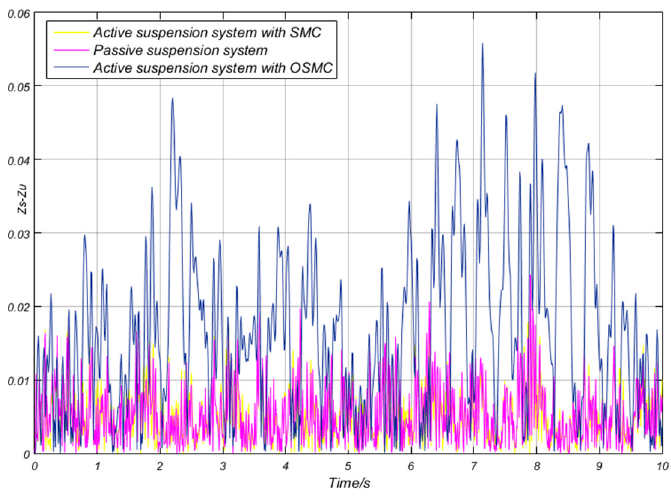
Figure 11. Vehicle body displacements of the three suspension systems.